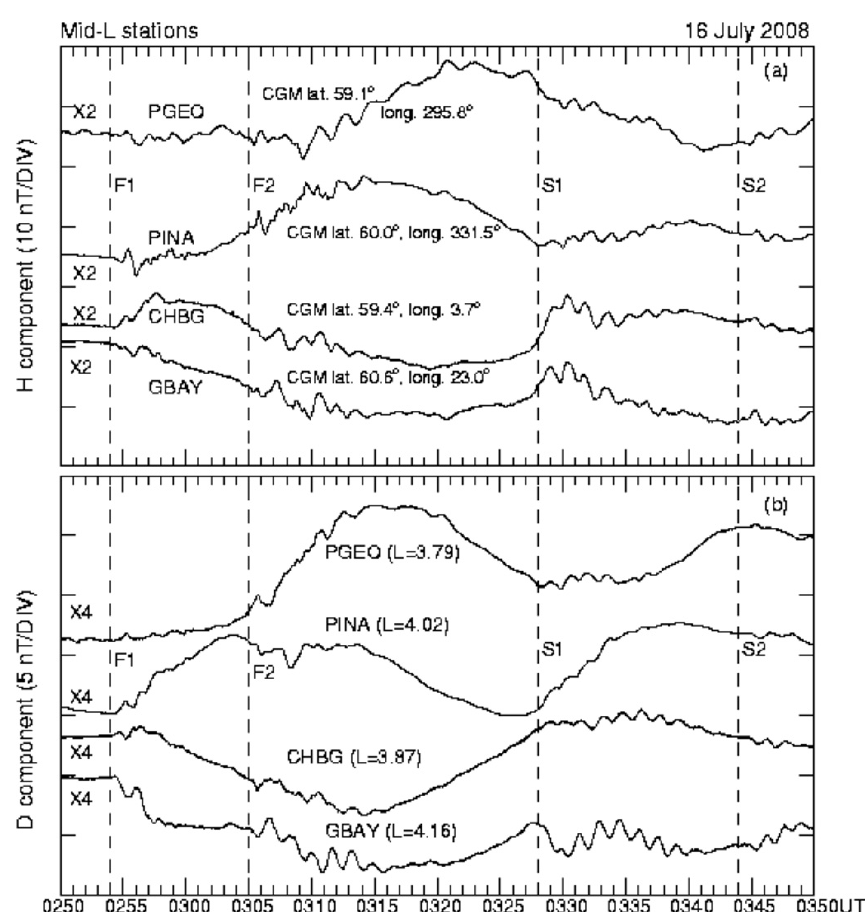
Fig. 3. In the same format as Fig. 2, except for the mid- L stations near L = 4.